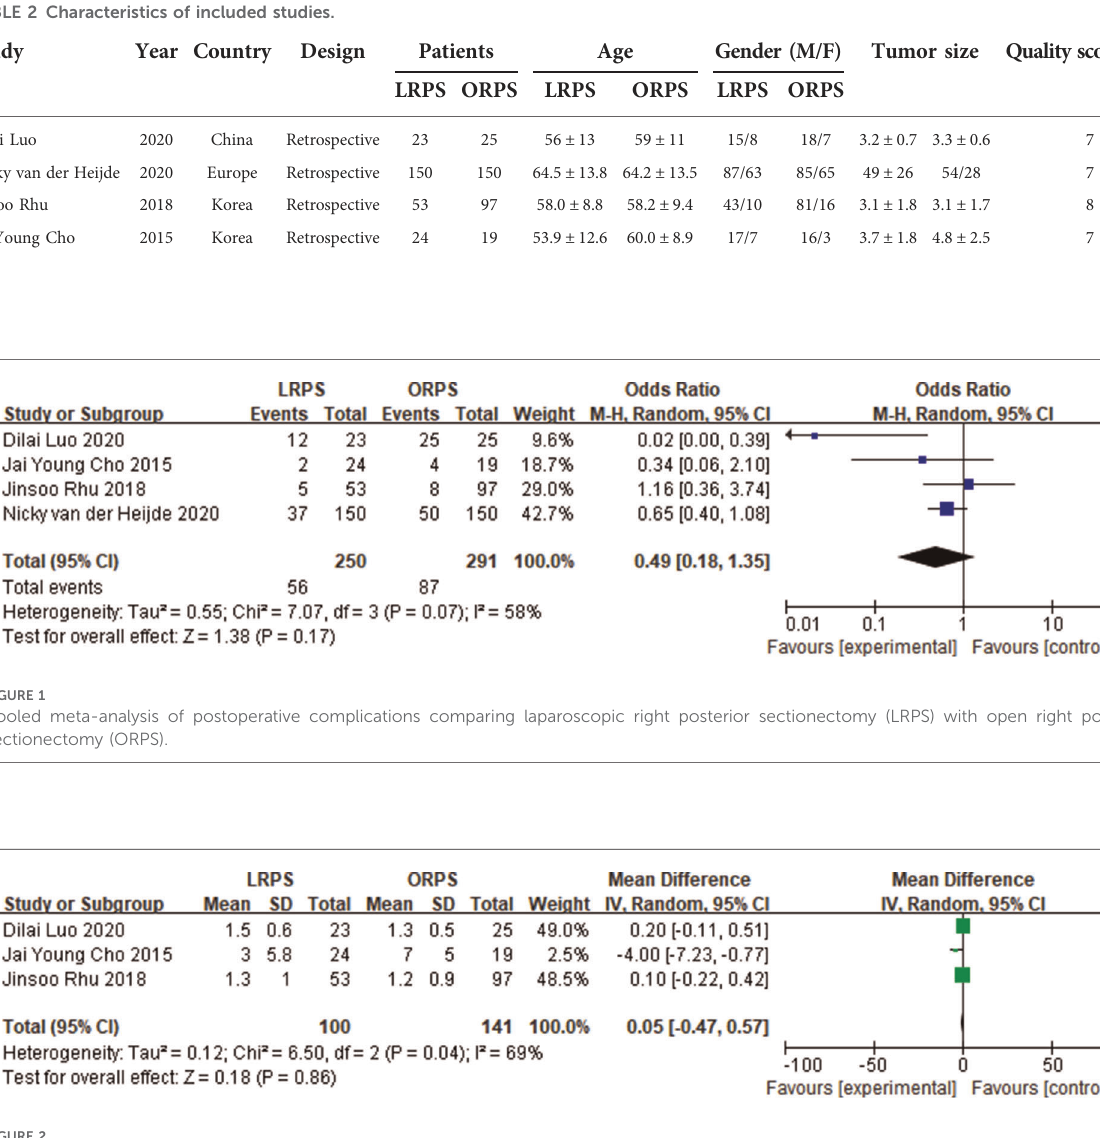
TABLE 2 Characteristics of included studies.